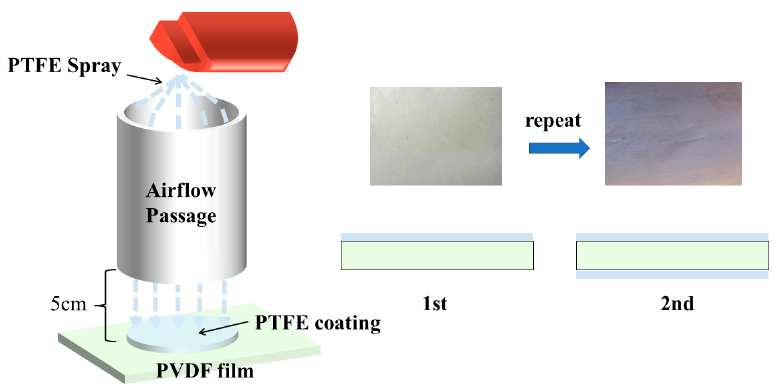
Figure 1. The schematic preparation process of PTFE–c–PVDF films.